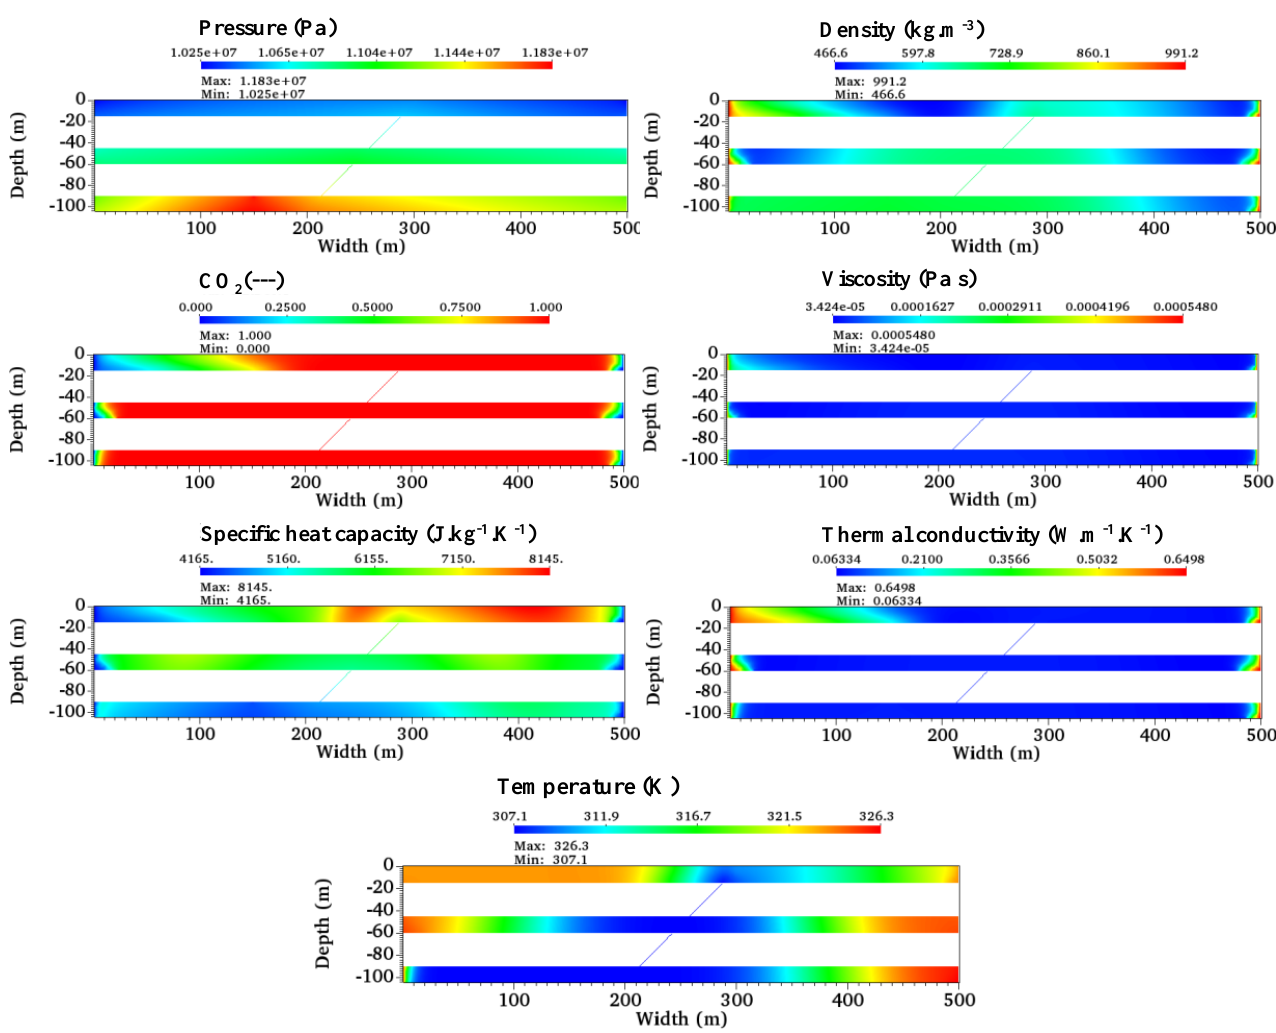
Figure 16. The CO 2 saturation at observation point 3 ( a – c ).